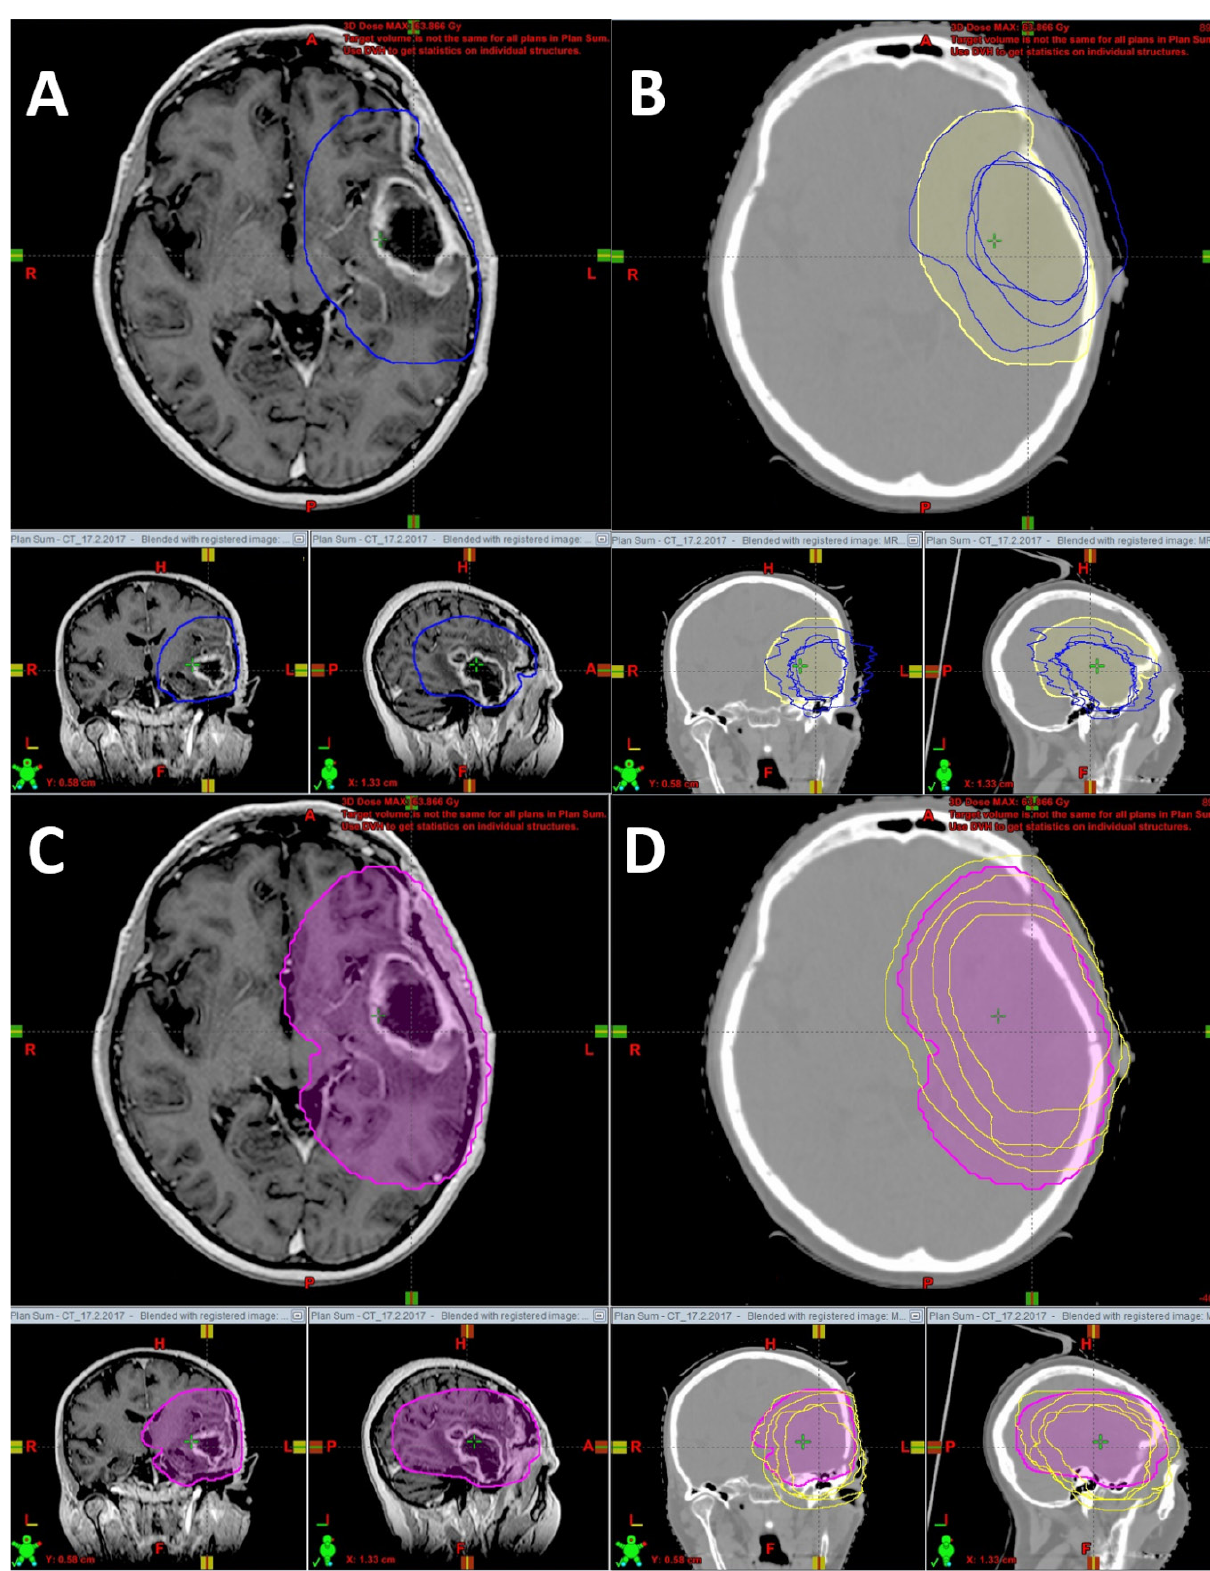
Fig. 2. Overplayed comparison of radiologists’ and radiation oncologists’ contours in selected representative patient. A: per pro- tocol PTV (planning target volume). B: original PTV in yellow color, overlayed by 4 radiologists’ contoure (4 blue lines). C: 80% isodose from original treatment plan overlayed by 4 radiologists’ estimate (4 yellow lines on D